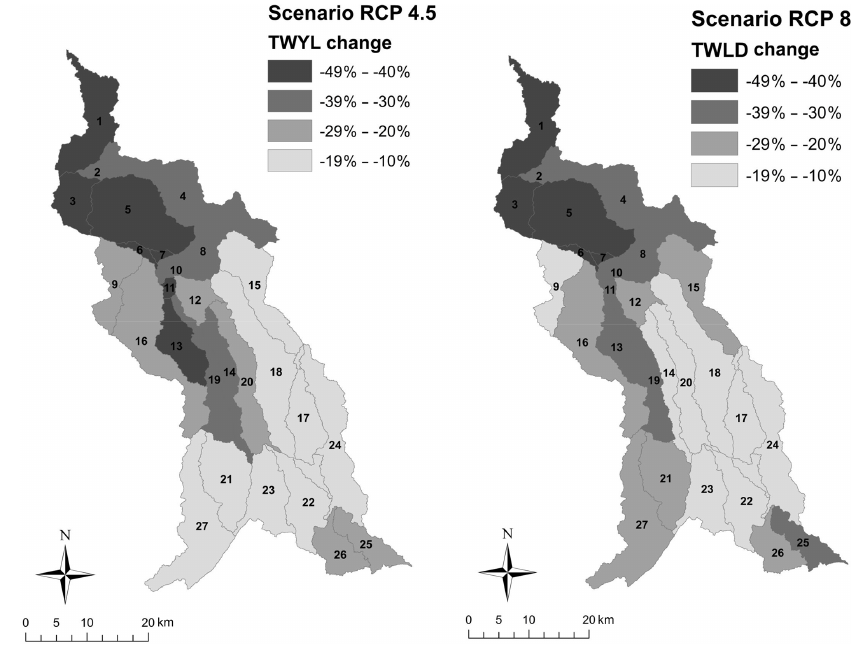
Figure 5. Changes of TWYL by sub-basins under future scenarios RCP4.5 and RCP8.5 for the period 2031 to